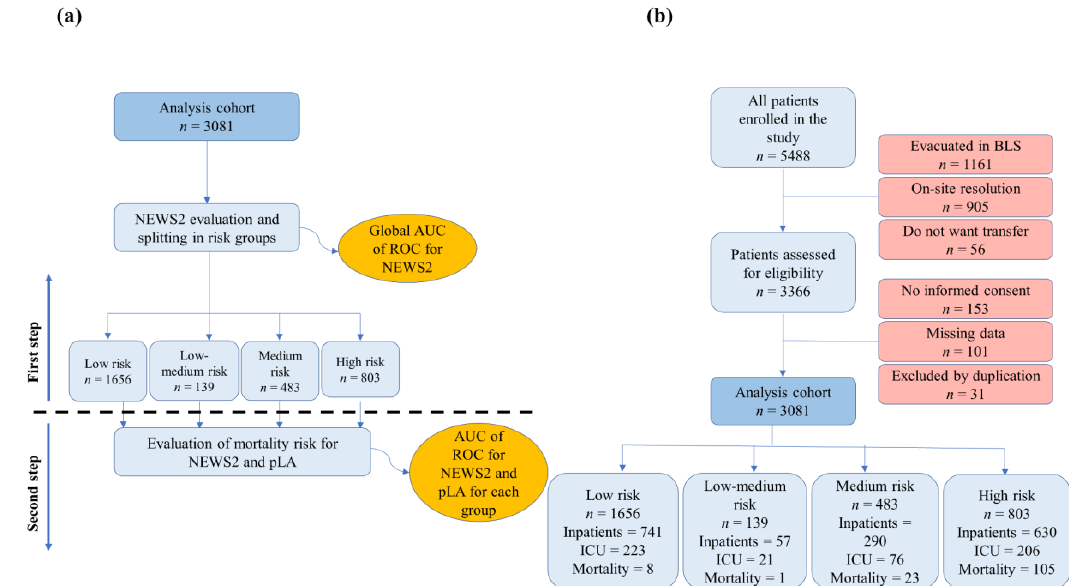
Figure 1. ( a ) The two-step analysis procedure. ( b ) Epidemiology diagram showing analysis population by groups derived from the risk stratification provided by the NEWS2. AUC: Area under the curve; BLS: Basic life support; NEWS2: National Early Warning Score 2; pLA: Prehospital lactate; ROC: Receiver operating characteristic.